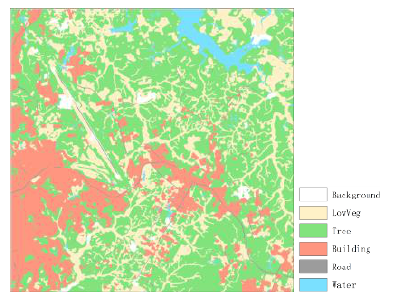
Figure 7. The best prediction by FPN-VGG